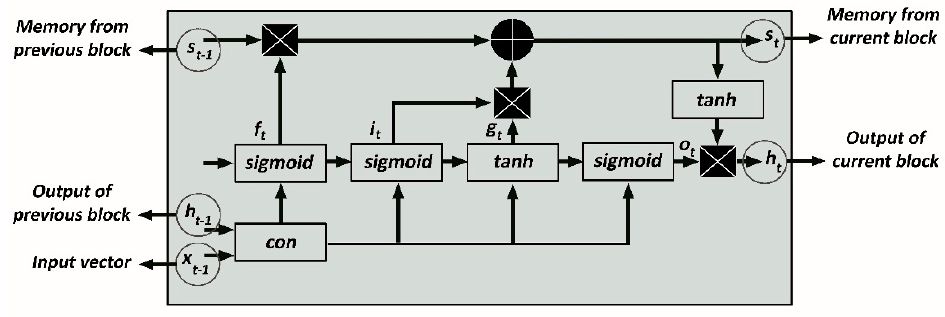
Figure 3. Schematic representation of long short-term memory (LSTM) unit structure.